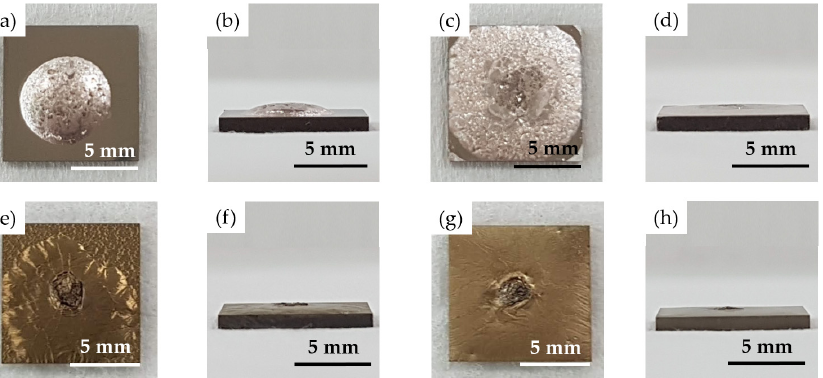
Figure 2. Top and transverse views after wetting tests at 850 °C/600 s for the Bag-8 filler ball on ( a , b ) Ag(1.5 µ )/Crofer, ( c , d ) Ag(5 µ )/Crofer, ( e , f ) Ag(1.5 µ )/Cu(1 µ )/Ti(0.5 µ )/YSZ, and ( g , h ) Ag(5 µ )/Cu(3 µ )/Ti(1 µ )/YSZ.